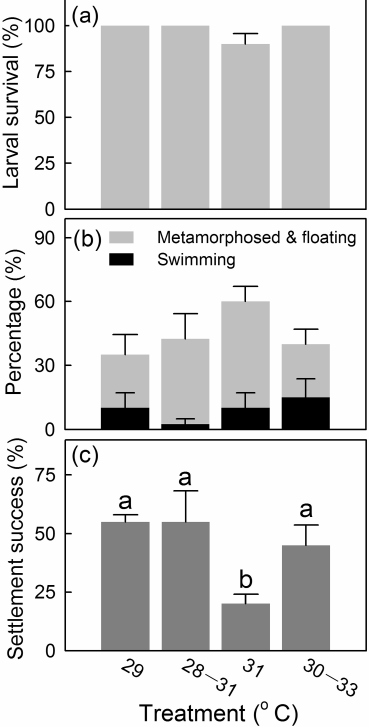
Figure 2. Percentage of P. damicornis larvae that (a) survived, (b) metamorphosed while floating and remained pear-shaped, and (c) successfully settled after 24h exposure to temperature treatments. Error bars represent 1 standard error of the mean (SEM) ( n = 4). Different letters denote significant differences between